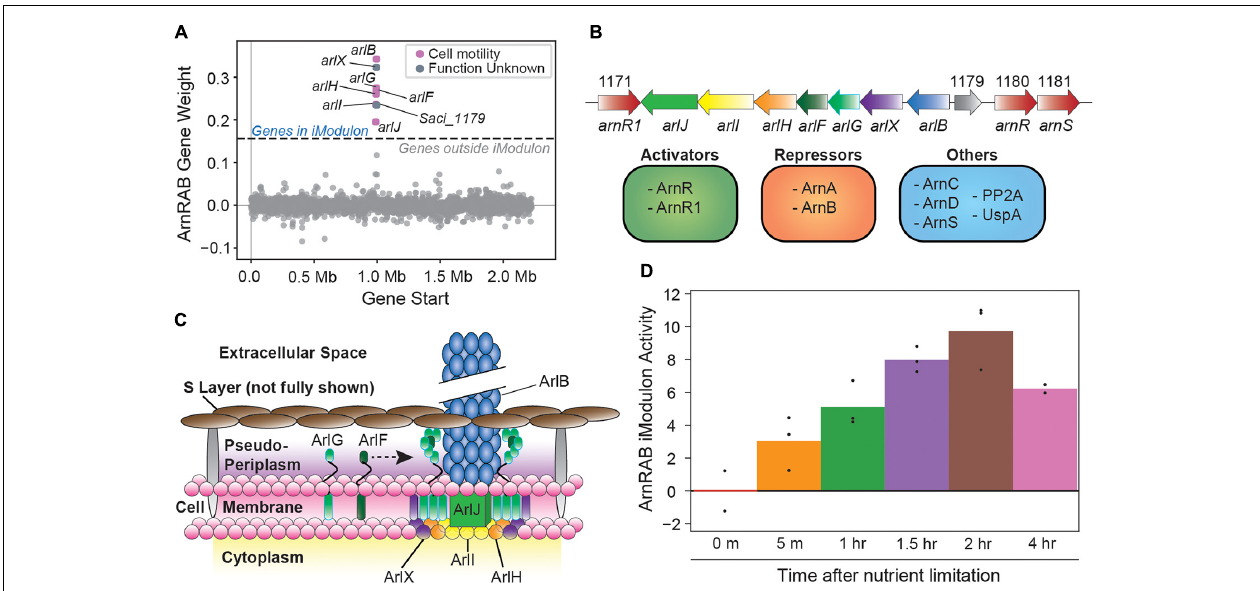
FIGURE 2 | Overview of the ArnRAB iModulon. (A) Scatter plot of the gene weights for the ArnRAB iModulon. The X -axis represents the genomic location and the Y -axis represents the weight of each gene in the independent component. The dashed lines represent the threshold beyond which genes of the independent component are included in an iModulon. (B) Gene map of archaellum formation operon (Lassak et al., 2013). Known regulatory elements are also listed (Reimann et al., 2012; Lassak et al., 2013; Haurat et al., 2017; Ye et al., 2020). (C) Structural map showcasing individual gene products from the archaellum formation operon and how each gene product integrates to form these archaeal motility pili (Beeby et al., 2020; Tsai et al., 2020). Note that the S-layer, which typically consists of SlaA (the stalk) and SlaB (the cap) is not fully shown. The stalks in particular are not displayed to highlight the structural organization of the archaellum operon proteins. (D) Bar plot depicting the ArnRAB iModulon activity over time in nutrient-limiting conditions. Bars represent averages and points represent individual replicate samples. All activity levels are relative to a chosen control condition (0 min after nutrient limitation in this